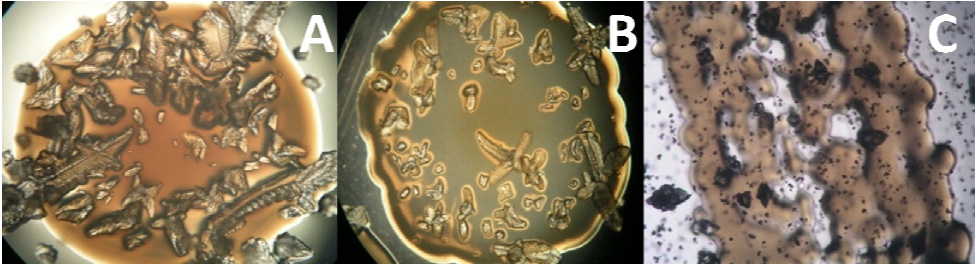
Figure 2. Growth of colonies with precipitates of phosphate in SS1 and SS2 solid media. ( A ): Struvite-forming colony in SS1 medium; ( B ): Struvite-forming colony in SS2 medium; ( C ): Struvite and spherulites biomass in SS1